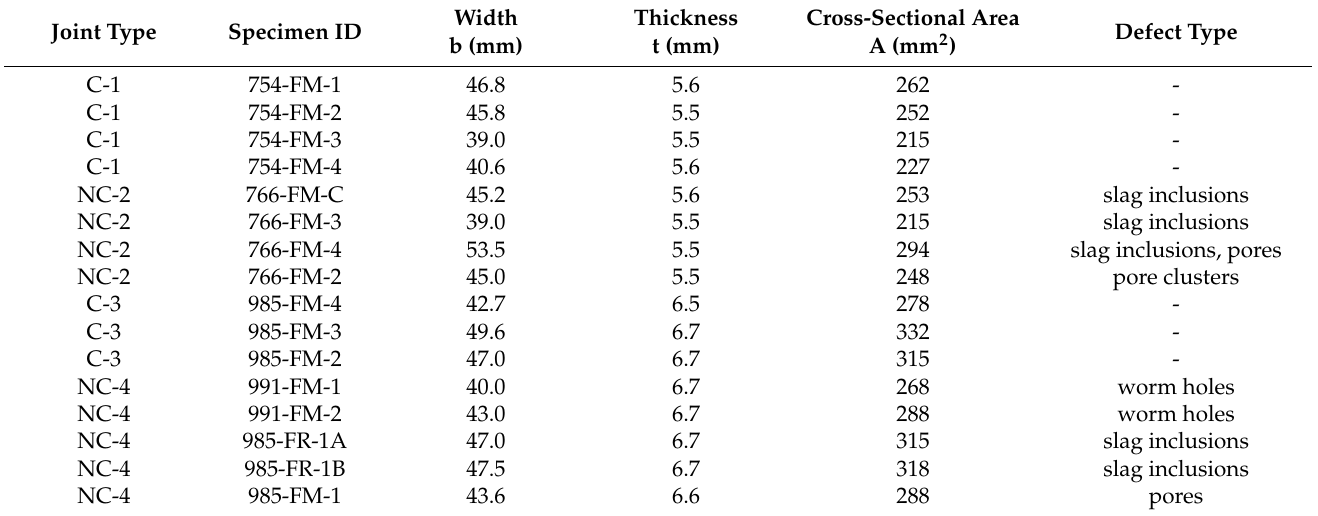
Table 1. Dimensions of the welded joints.